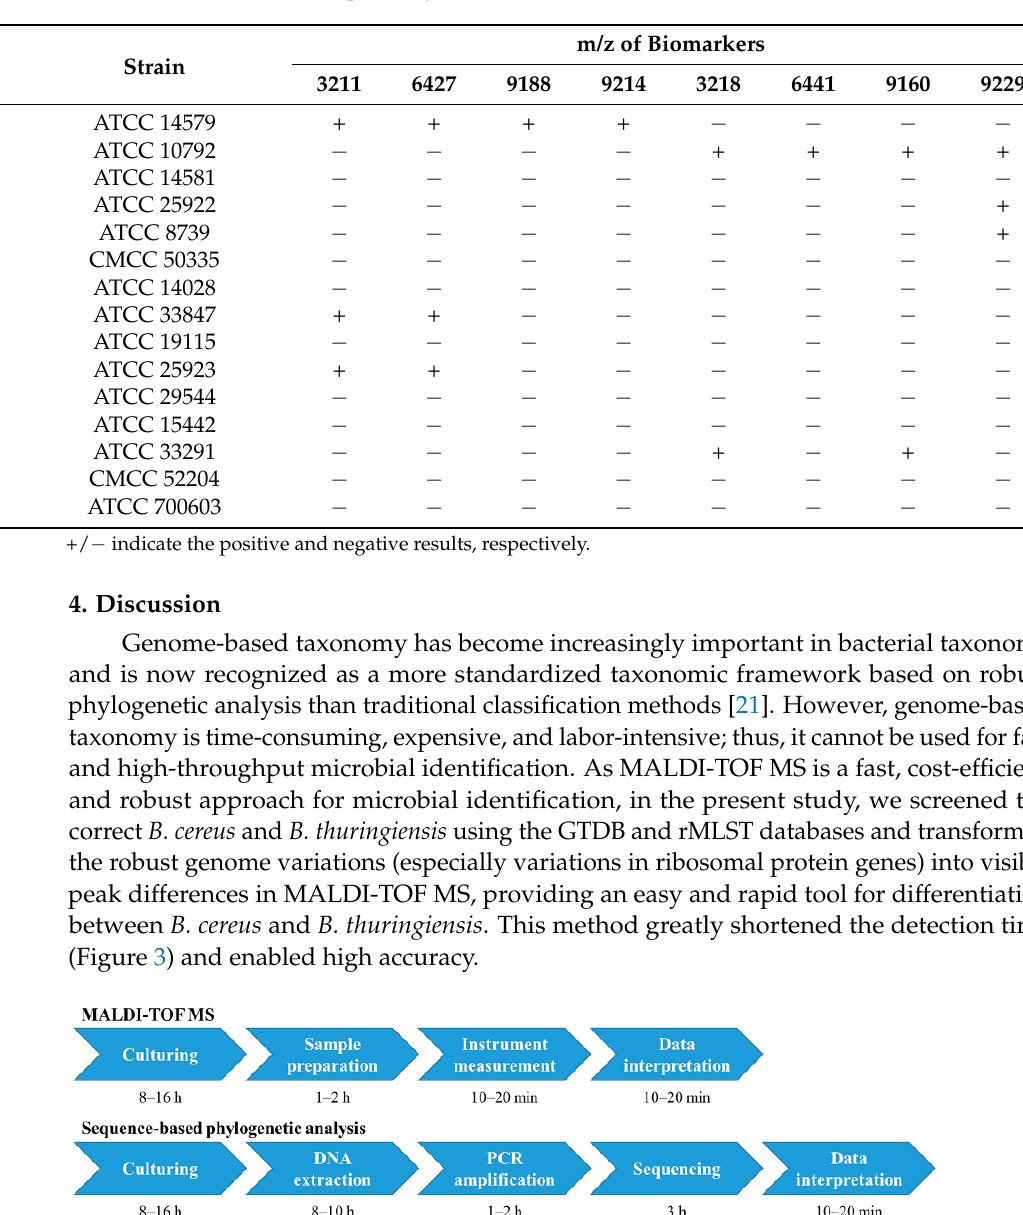
Table 3. Bacillus strains and other common foodborne pathogens tested in the present study and MALDI-TOF MS results of specificity tests.